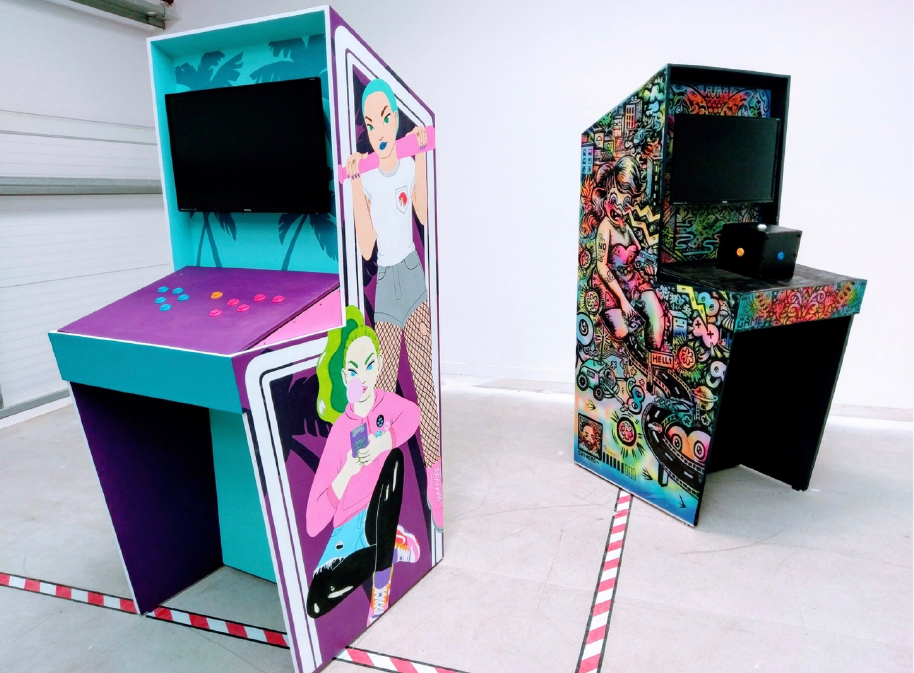
Figure 2. Games are for Everyone uses arcade cabinets as artworks in their own right which also house experimental games, providing participative draw and supporting ecologies of participation for players, spectators and those who wish to ‘view’ the cabinets. Image copyright by We Throw Switches (2017, reprinted with